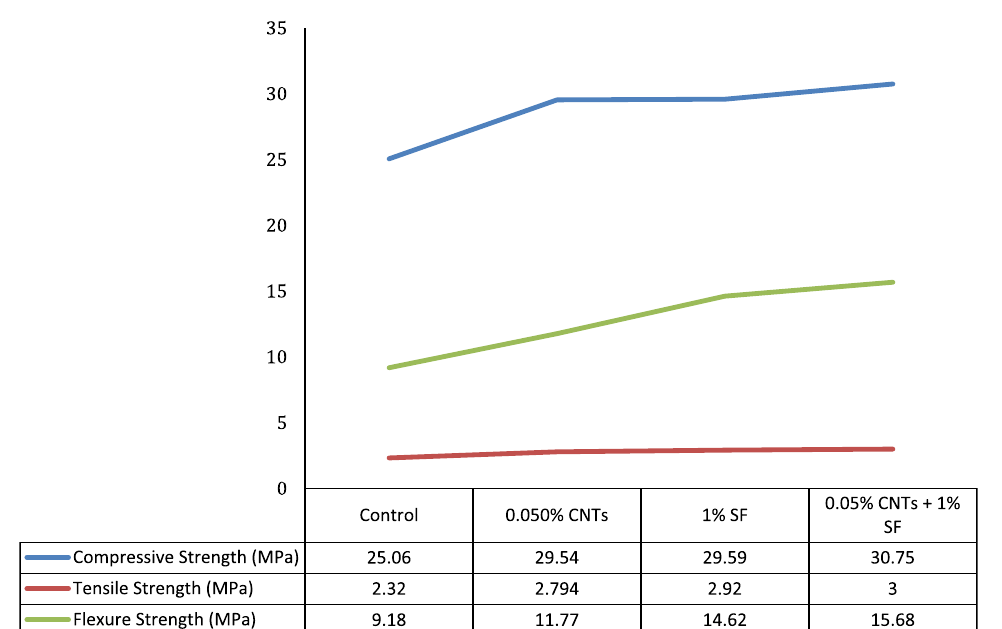
Fig. 13 Effect of mixing both steel fibers and CNTs on the strength compared to previous specimens